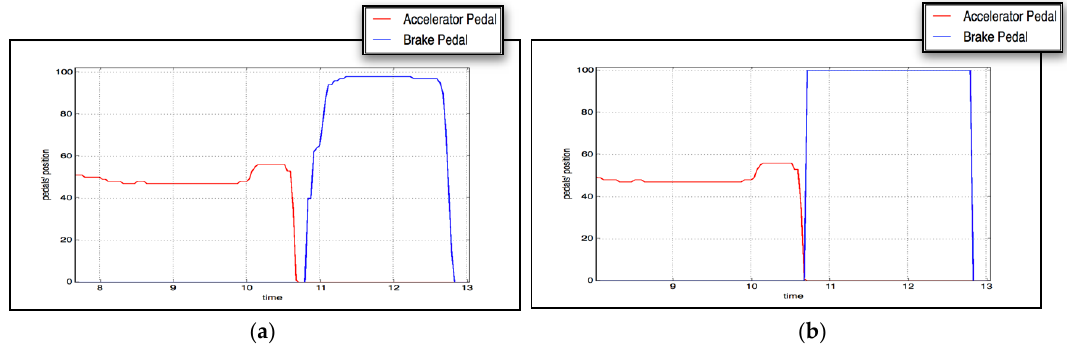
Figure 12. Sample dynamics of accelerator and brake pedals in two cases of emergency braking: without ( a ) and with ( b ) automated braking activated by the driver-supporting agent.